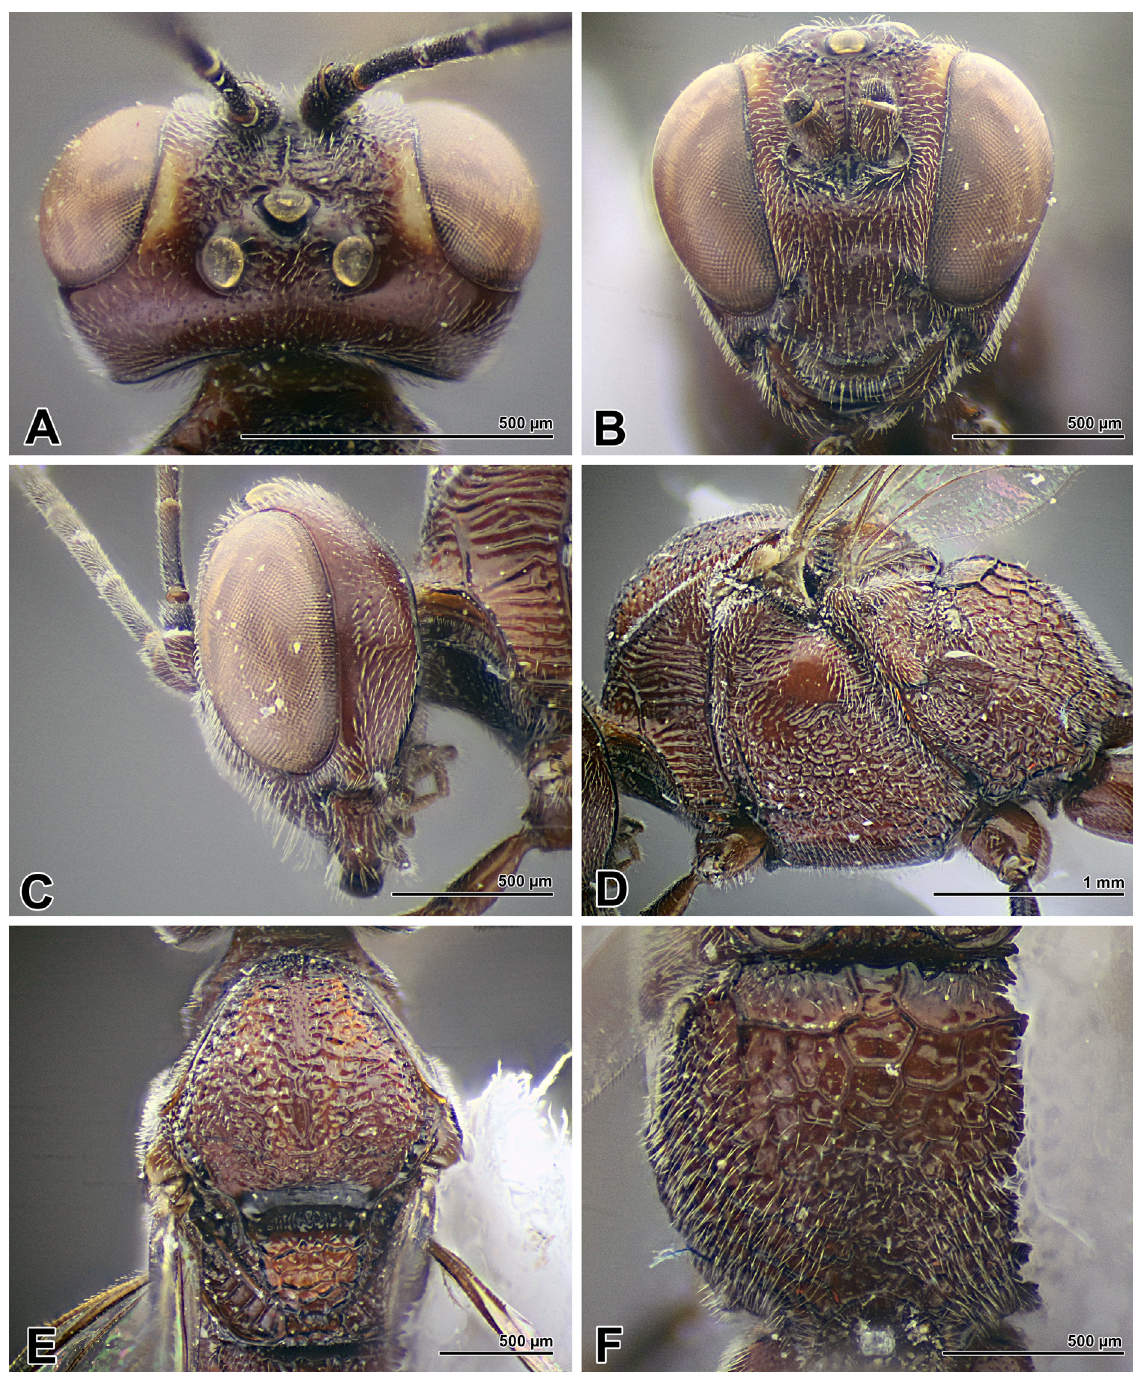
Fig. 6. Anomalon cruentatum (Geoffroy, 1785), ♀, DPPZ. A . Head, dorsal view. B . Head, frontal view. C . Head, lateral view. D . Mesosoma, lateral view. E . Mesoscutum, dorsal view. F . Propodeum, dorsal